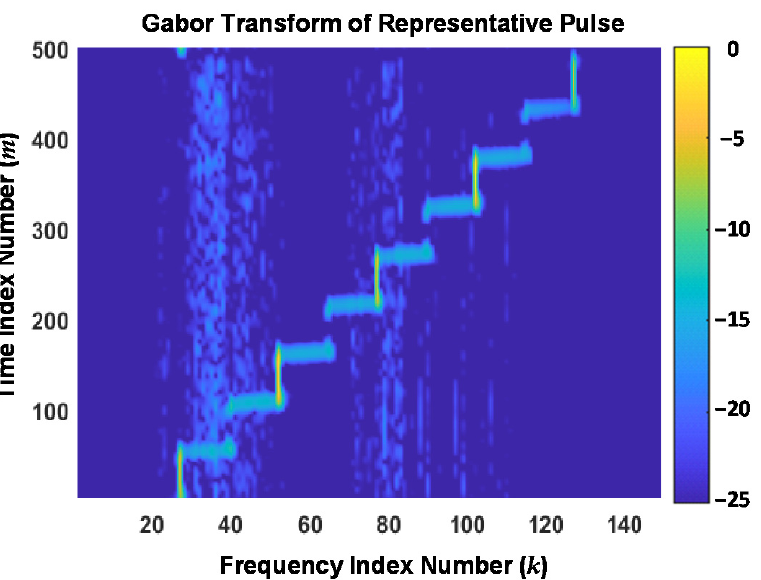
Figure 5. Normalized time-frequency Gabor transform response of the same representative DUT stimulated output used to generate the Figure 3 time domain magnitude response. Relative to the spectrogram response, it is evident in Figure 5 that the highest degree of Gabor localization occurs around 3-of-9 frequency step regions ( k = 55, 82, 109) and